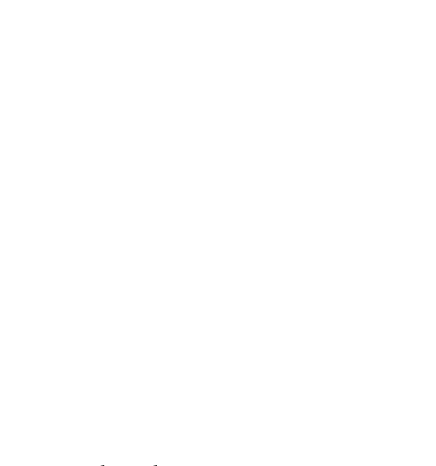
Figure 14. Mean squared error versus number of epochs for training and test data.